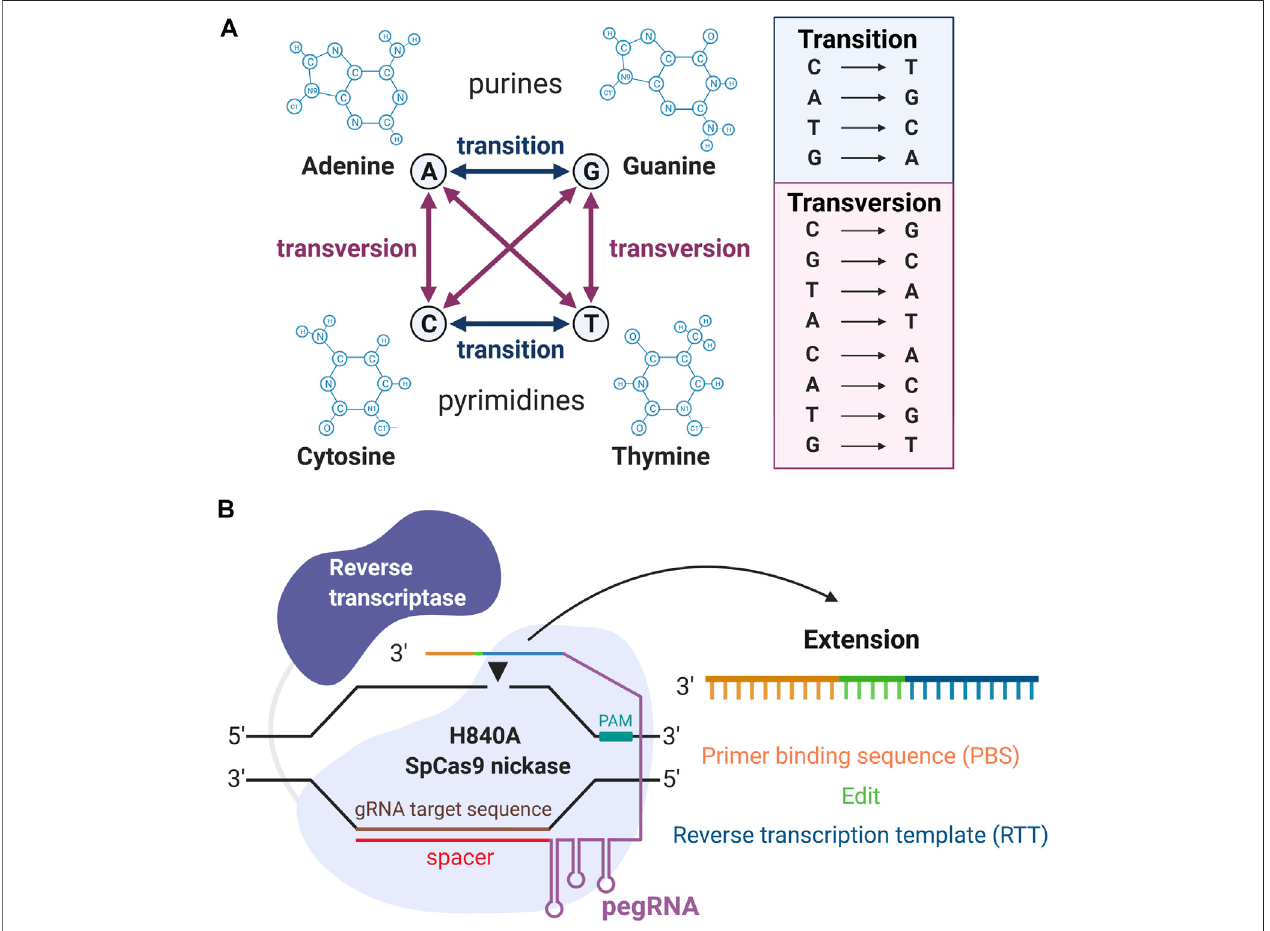
FIGURE 1 | Overview of prime editing (PE). (A) Illustrations of all 12 kinds of DNA substitutions. (B) The machinery of PE. From the 5 ′ to the 3 ′ end, the pegRNA contains the spacer, gRNA scaffold, reverse transcription template (RTT), and primer binding sequence (PBS). “ Created with BioRender ” .